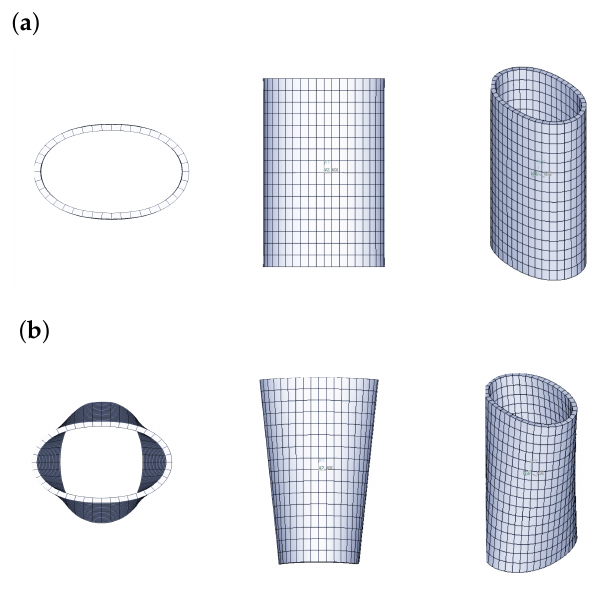
Figure 6. Pure radial ( a ) and radial shearing ( b ) mode shapes in the top, lateral and isometric view.